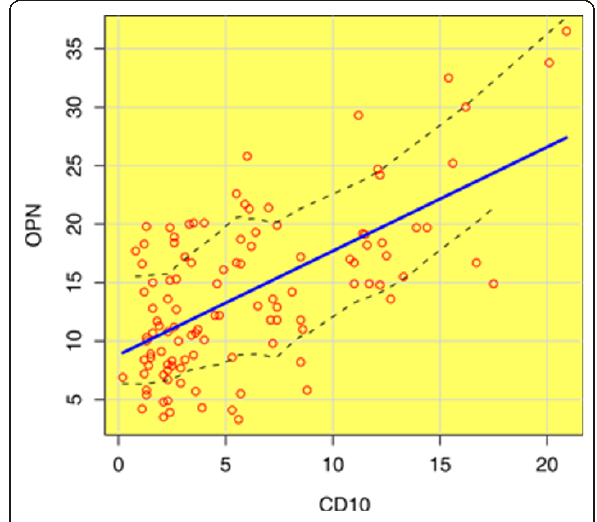
Figure 9 Pearson ’ s correlation of CD10 with OPN showing the trend line and least square lines (dotted)